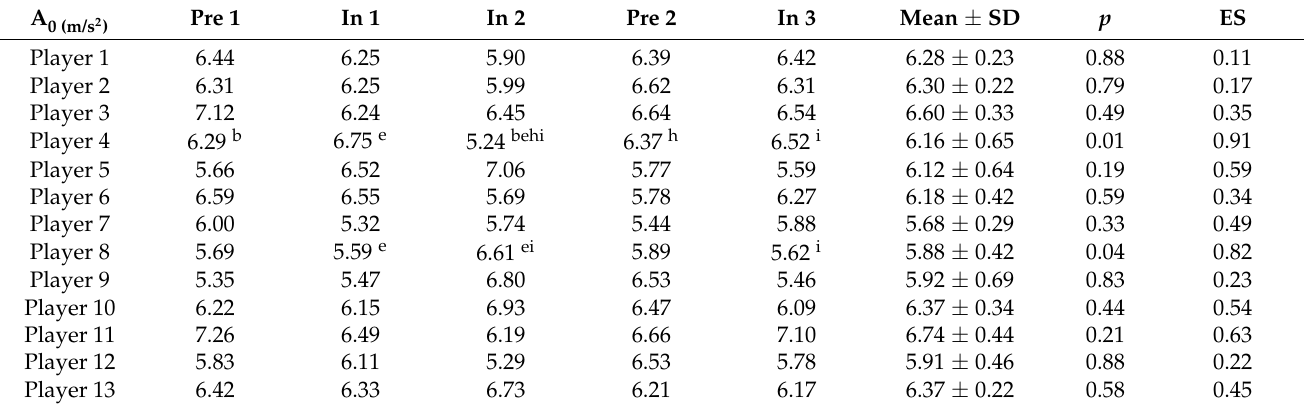
Table 1. Theoretical maximal acceleration per player period and difference in